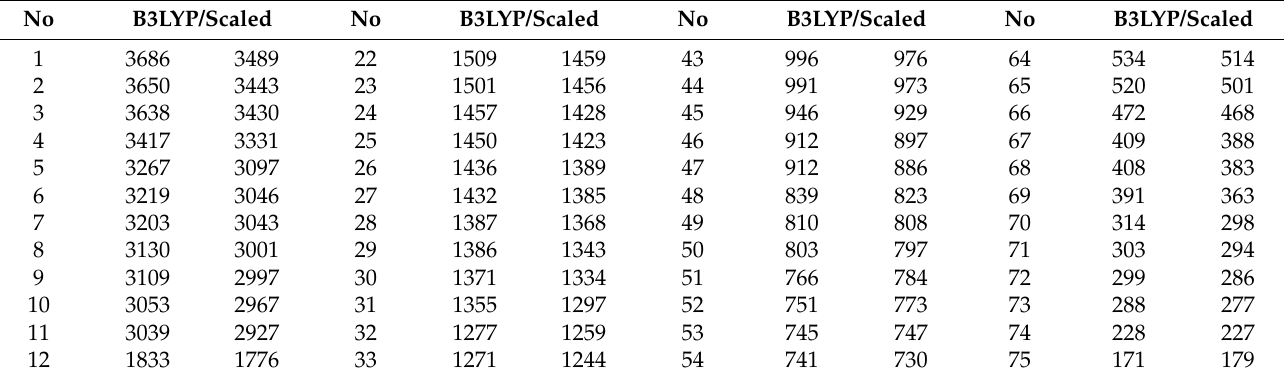
Table 4. Adenine–thymine pair: theoretical B3LYP/6-31G* frequencies and frequencies calculated with the scaled force matrix (cm − 1